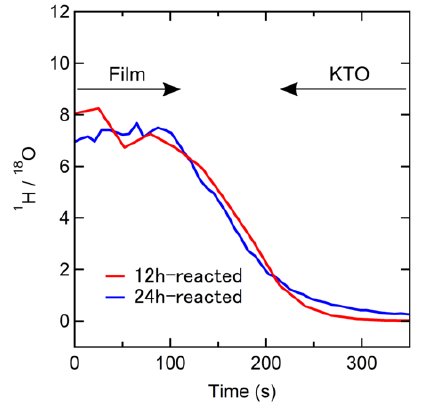
Figure 3. SIMS profiles of the SrVO 3 films on KTaO 3 substrates after CaH 2 treatment for 12 h and 24 h. Secondary ion intensity ratio of 1 H/ 18 O plotted with respect to sputtering time.